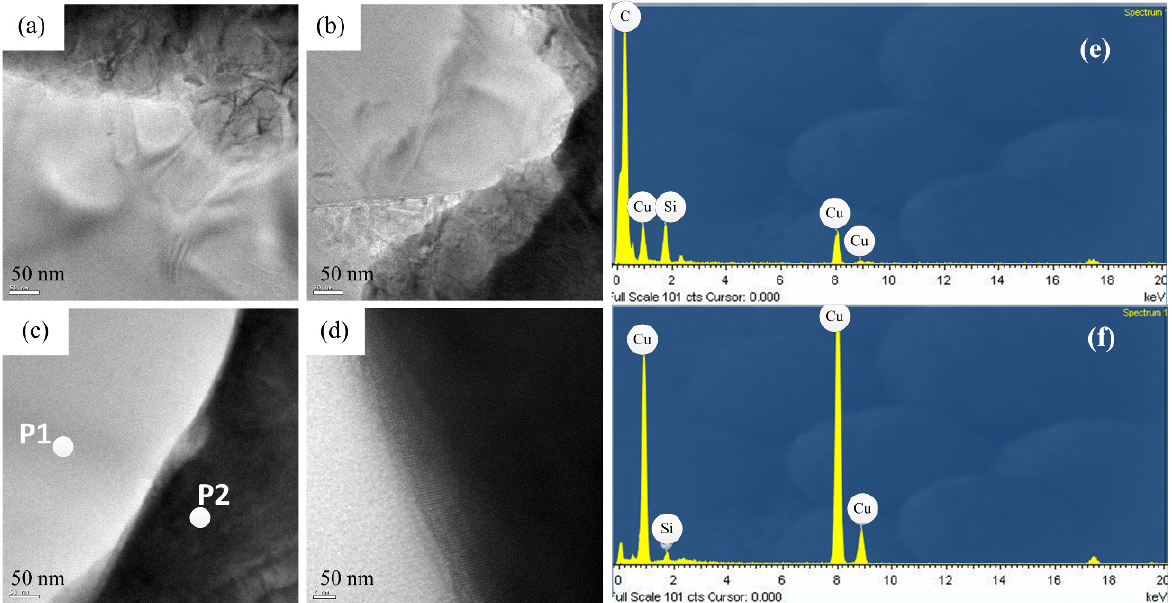
Figure 10. TEM micrographs of specimen B at different positions, ( a ) position 1, ( b ) position 2, ( c ) position 3, ( d ) position 4, ( e ) the element composition of P1, and ( f ) the element composition of P2.